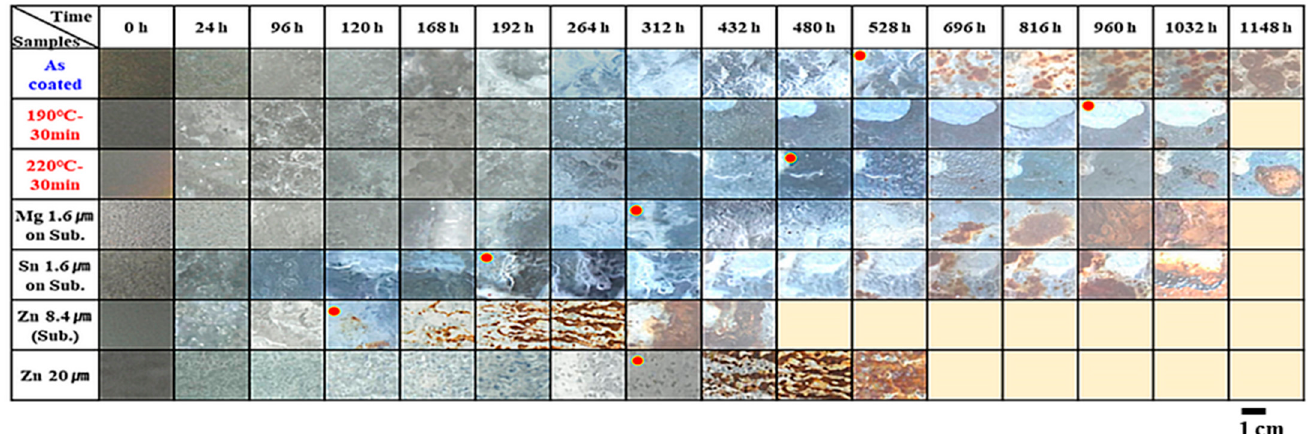
Figure 6. SST images of Sn/Mg and other films. The red dot indicates the initiation point of red rust.